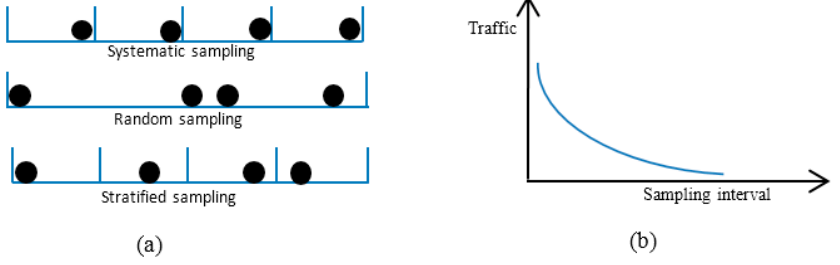
Figure 1. An illustration of sampling techniques: ( a ) Nonadaptive sampling; ( b ) The concept of adaptive sampling [12].